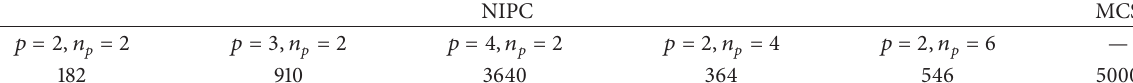
Table 3: The number of samples to UQ by NIPC and MCS.